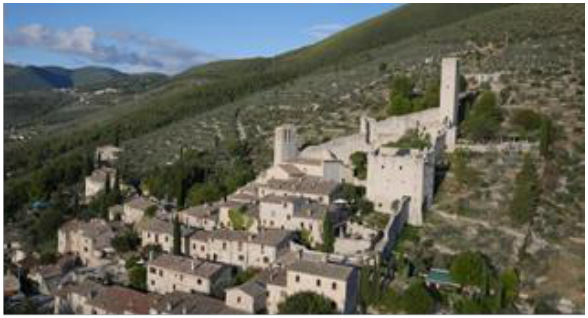
Figure 2. Aerial photo of the project site